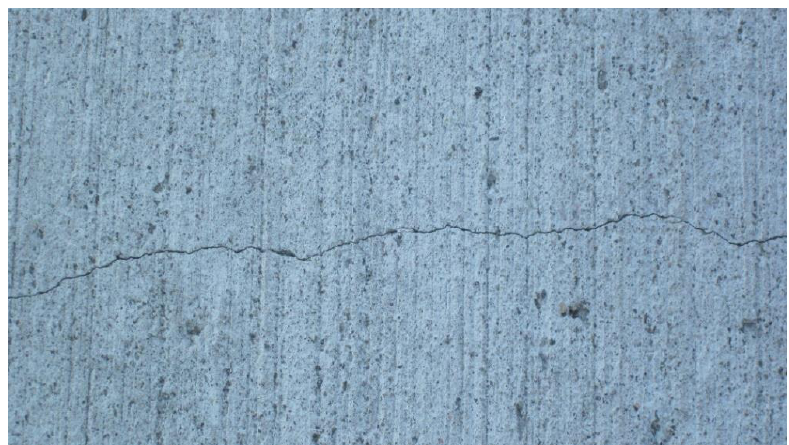
Figure 2. Early-age transverse crack in a concrete pavement slab which widened over time; this crack started within 56 days of concrete placement; the slab was cured using curing compound.